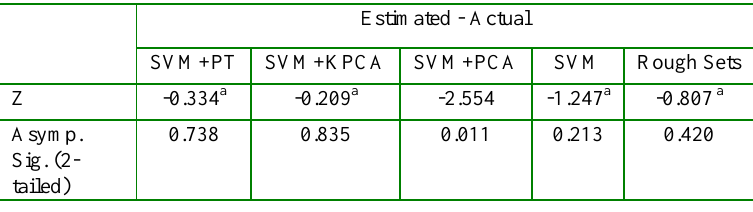
Table 4. Wilcoxon Signed Ranks Tests